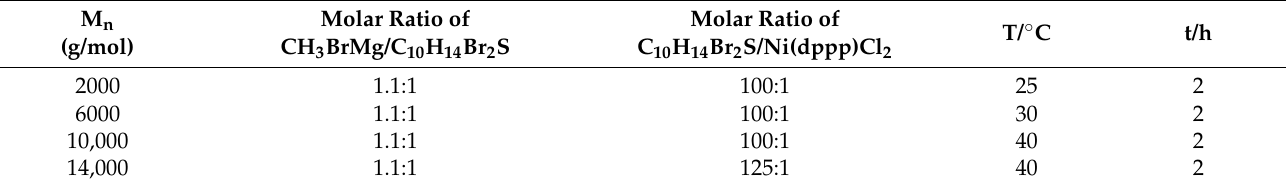
Table 1. Synthesis conditions of P3HT with different molecular weights.